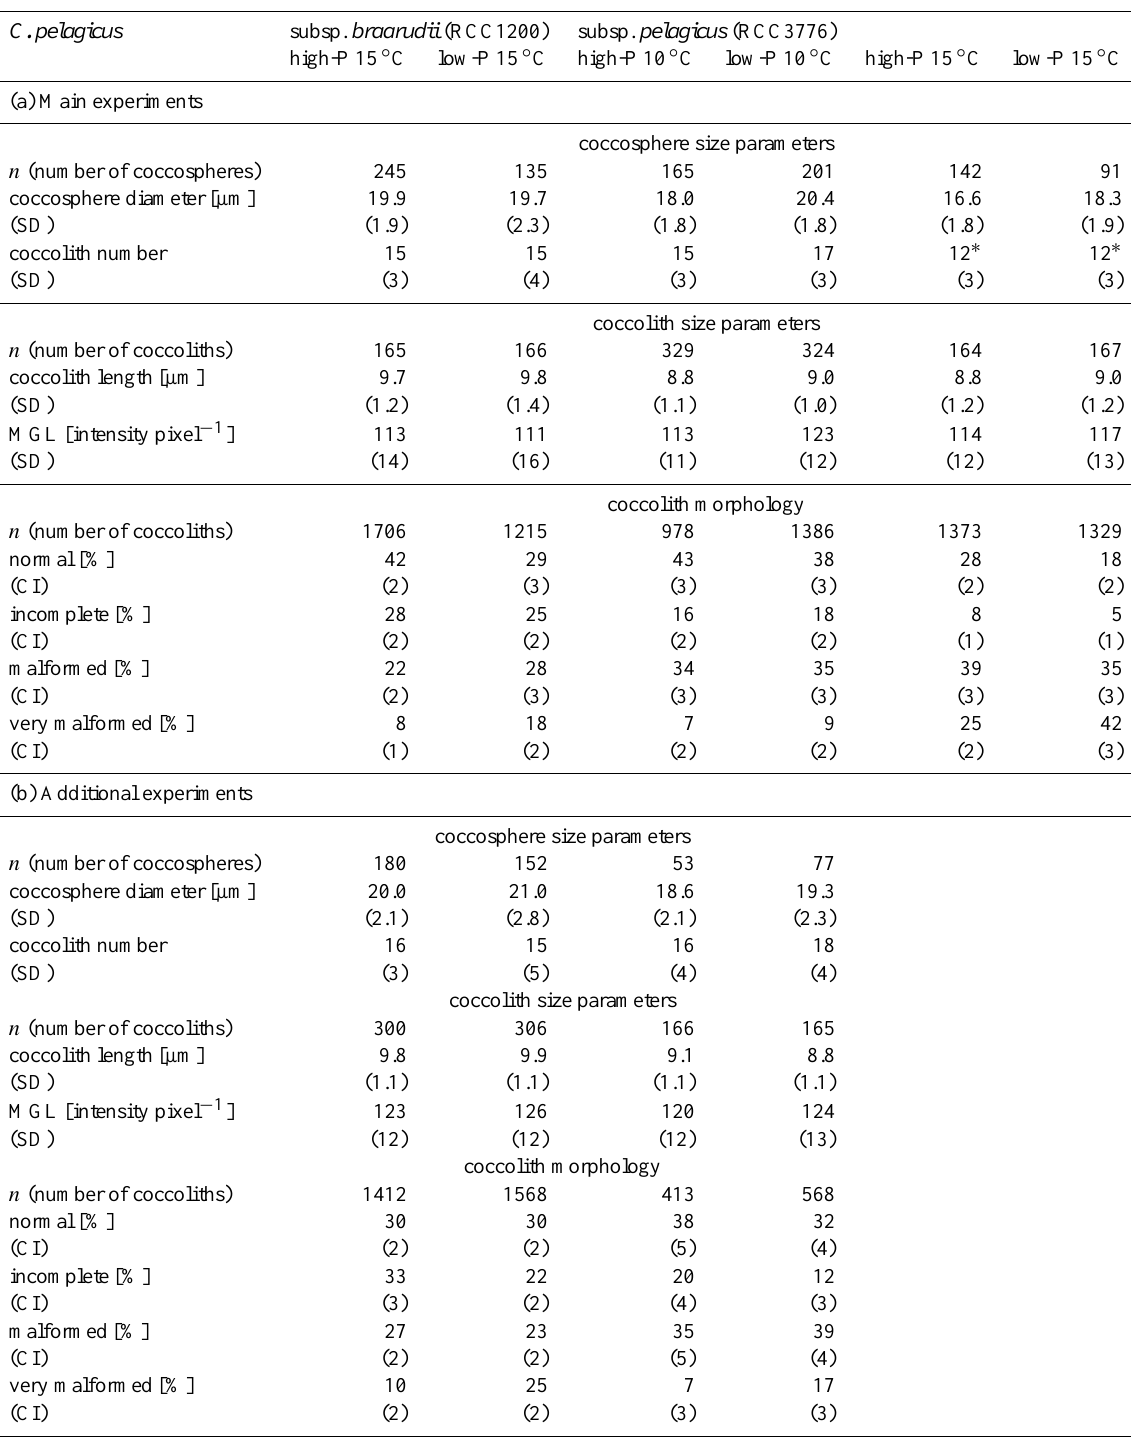
Table 3. Coccosphere and coccolith size parameters as well as coccolith morphology from paired high-P and low-P media batch experiments ( n = 3) with Coccolithus pelagicus subsp. braarudii (RCC1200) grown at 15 ◦ C, and subsp. pelagicus (RCC3776) grown at 10 and 15 ◦ C. Reported is sample size ( n ), average value of pooled triplicate batch cultures with standard deviation (SD) or 95% confidence interval (CI) in